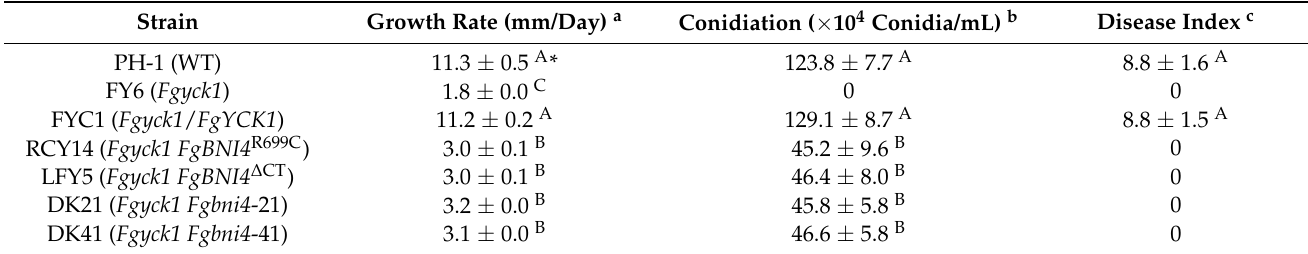
Table 2. Vegetative growth, conidiation, and virulence of F. graminearum strains.